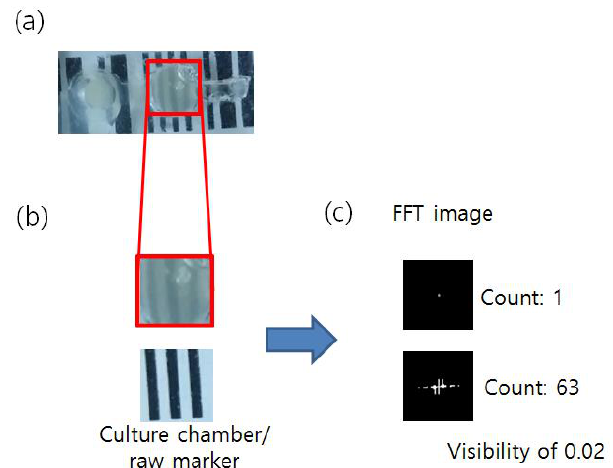
Figure 4. Bacterial growth detection experiment replicated on the fabricated PDMS devices: ( a ) bacterial cell culture on the PDMS device; ( b ) the blurred marker due to growth of the bacteria in the culture chamber of the PDMS device for 4 h ( up ) and the clear marker ( down ); and ( c ) the FFT spectrum count reduced due to the blurred marker. Count indicated the number of the nonzero pixels in the FFT image. The visibility was calculated by dividing the current count (1) with the count of the starting point (63).